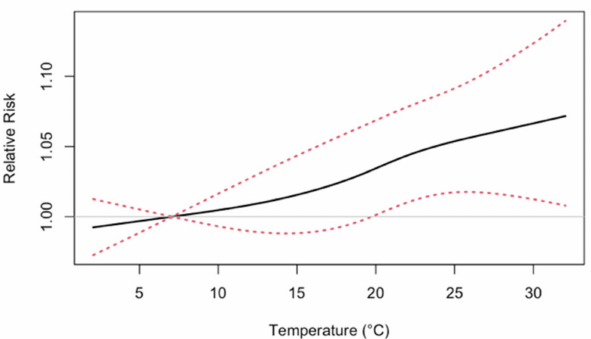
Figure 2. Estimated nonlinear associations between 3-day moving averages of minimum temperature on all internal-cause emergency department visits in Atlanta, 1993 to 2004. The exposure-response function has a reference temperature of 7.07 ◦ C, and dotted lines denote the 95% pointwise confidence interval